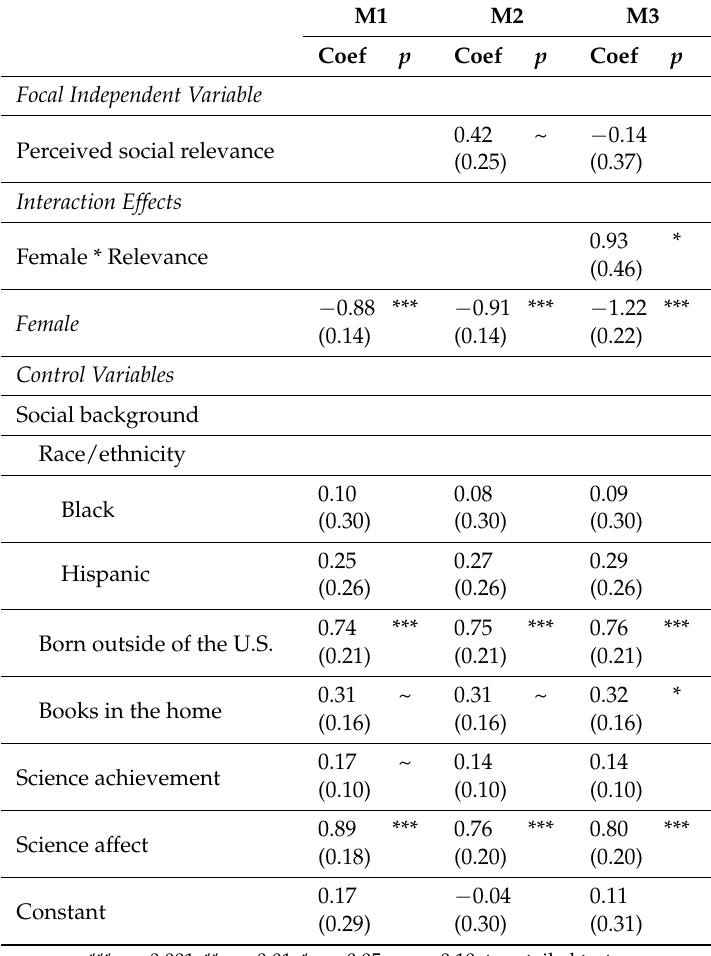
Table 2. Results from logistic regression models predicting expectations to major in any STEM field (Coefficients with standard errors in parentheses) (N =